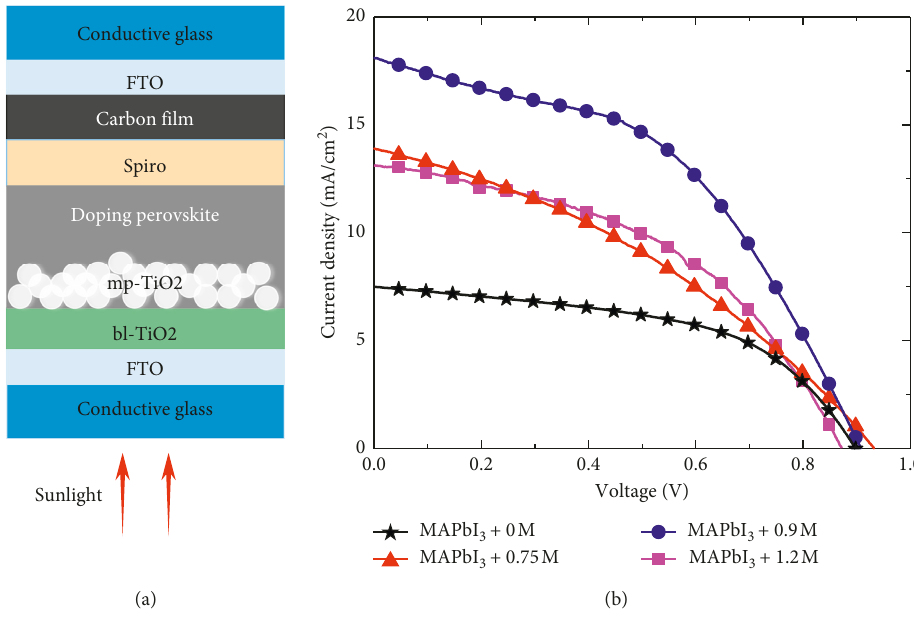
Figure 6: (a) Device structure diagram. (b) Photocurrent voltage density reverse scan (RS) curve of Sample+0M, Sample+0.75M, Sample+0.9M, and Sample+1.2M. Table 1: Detailed parameters for reverse scanning of Sample+0M, Sample+0.75M, Sample+0.9M, and Sample+1.2M. Samp